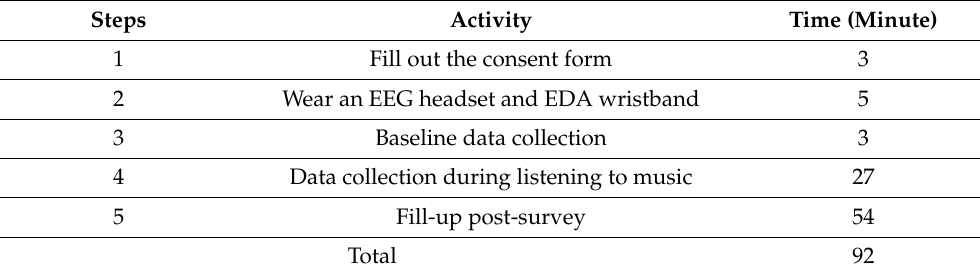
Table 2. Experimental protocol.